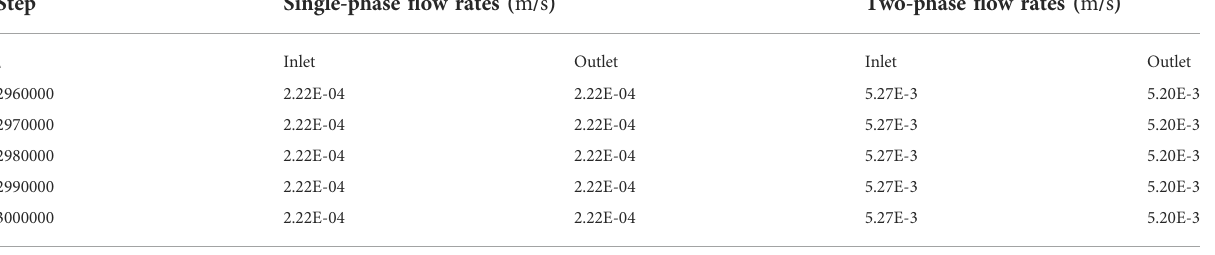
TABLE 3 The inlet and outlet fl ow rates of the single-phase and the default two-phase fl ow case.